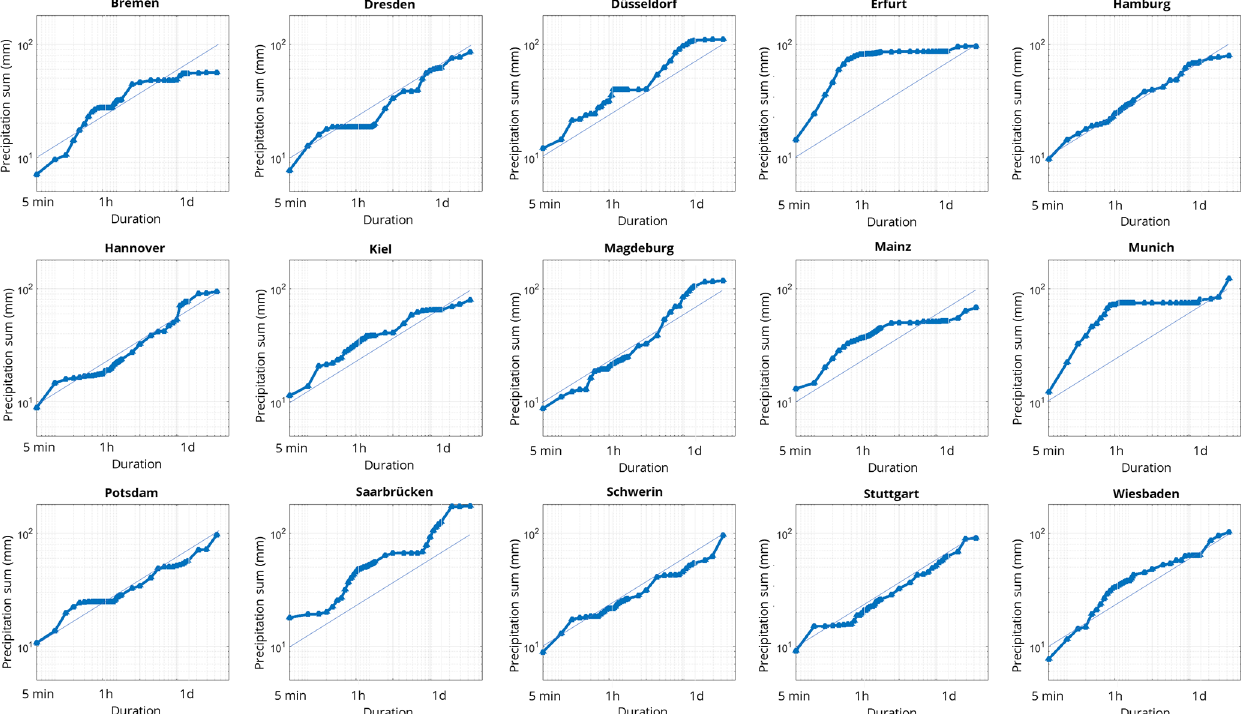
Figure 7. Depth–duration relationships of rain records for single pixels at rain gauge locations within state capitals of the German federal